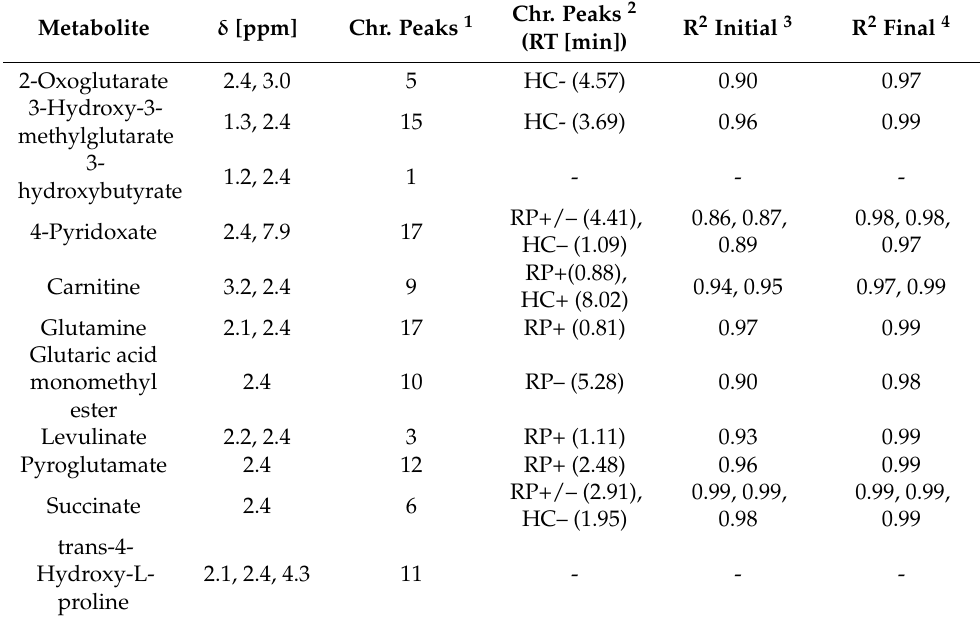
Table 2. Identified and quantified metabolites belonging to the example region between 2.47 and 2.37 ppm. The table shows for each compound the diagnostic chemical shifts for their identification and quantification, the number of chromatographic peaks detected in the mass dataset, the chromato- graphic peak(s) identified by the correlation with NMR data, and the value of Pearson’s correlation coefficient in the first and second deconvolution